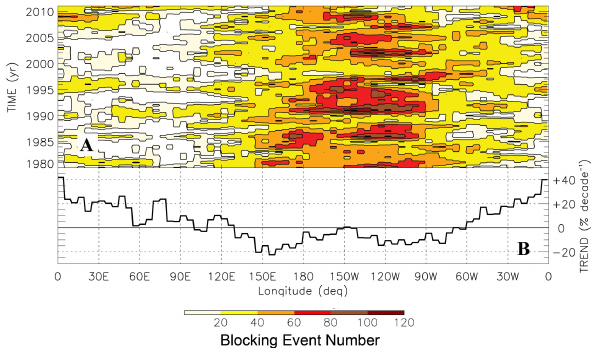
Fig. 6. (A) Contour of the annual number of blocked days for each longitude sector (5 ◦ wide) from 1980 to 2011. Blocked days are calculated from. ECMWF ERA INTERIM Re-Analysis of Geopo- tential height at a 500-hPa field on a regular grid of 1 ◦ × 1 ◦ (Sim- mons et al., 2006), following the procedure described in Scarchilli et al. (2011). (B) Trend of the annual number of blocked daytime series for each longitude sector (5 ◦ wide), expressed as the ratio be- tween the trend per decade and the average of the time series over the entire period